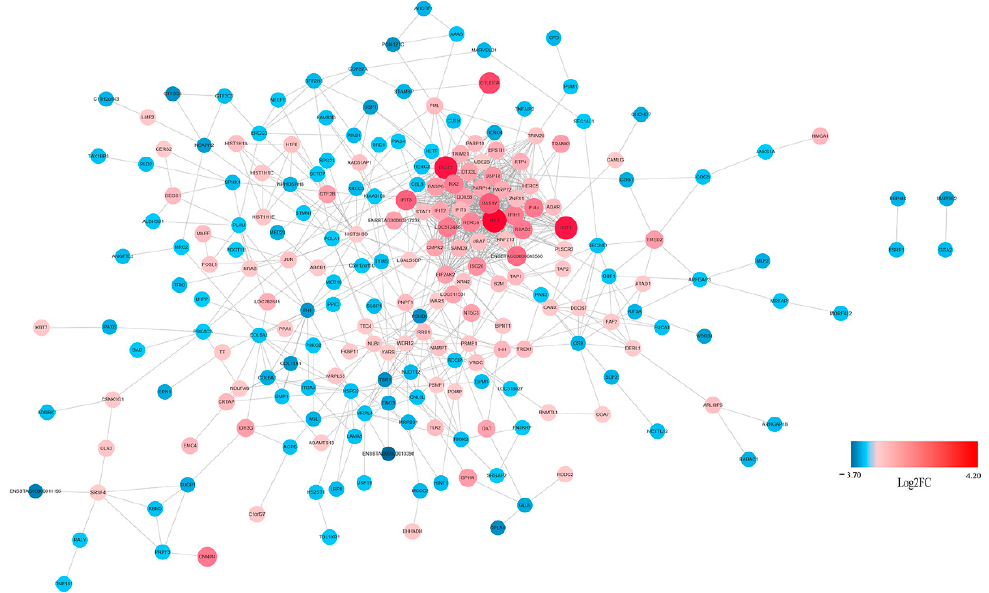
Figure 10. PPI network of the selected DEPs based on STRING analysis results and fold change information. The network nodes represent DEPs. The up-regulated proteins are shown in red, and the down-regulated proteins are shown in blue, with the gradient showing the extent of expression. The size of the node indicates connectivity. A detailed representation of DEPs is provided in Table S5.